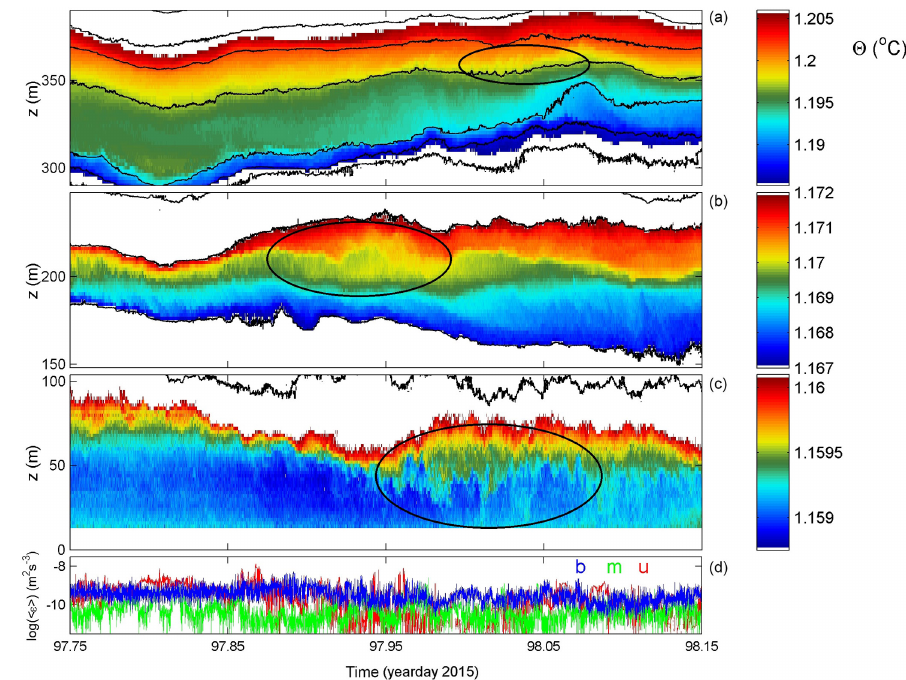
Figure 6. As Fig. 4, but associated with Fig. 5 and using different colour